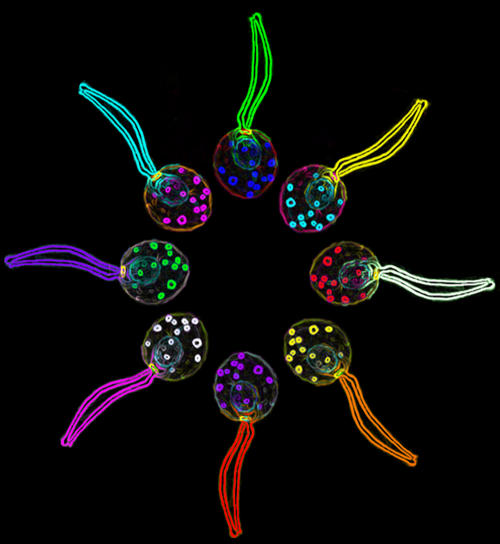

Chlamydomonas cells with flagella, plasma membrane, nucleus, and chloroplast nucleoids highlighted in neon. (Image: Jessica Feldman)